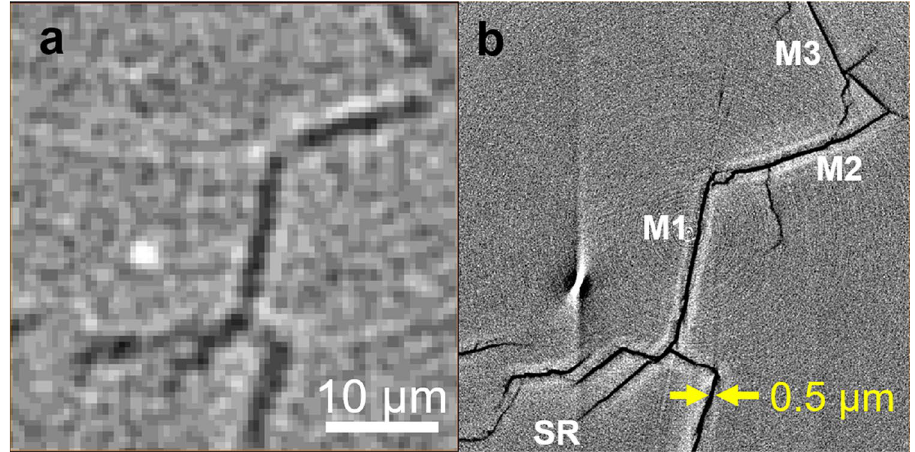
Figure 7. Median cracks. ( a ) Cross sectional image of median cracks observed by micro-CT, ( b ) Cross sectional image of median cracks observed by nano-CT.